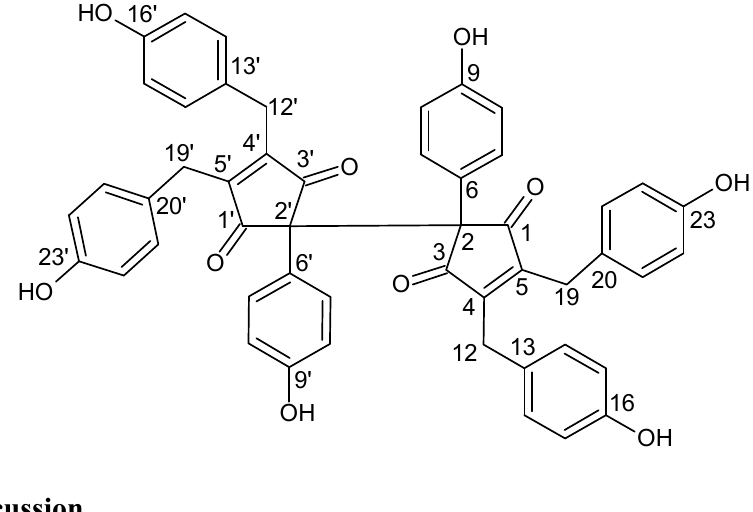
Figure 1. Chemical structure of nostotrebin